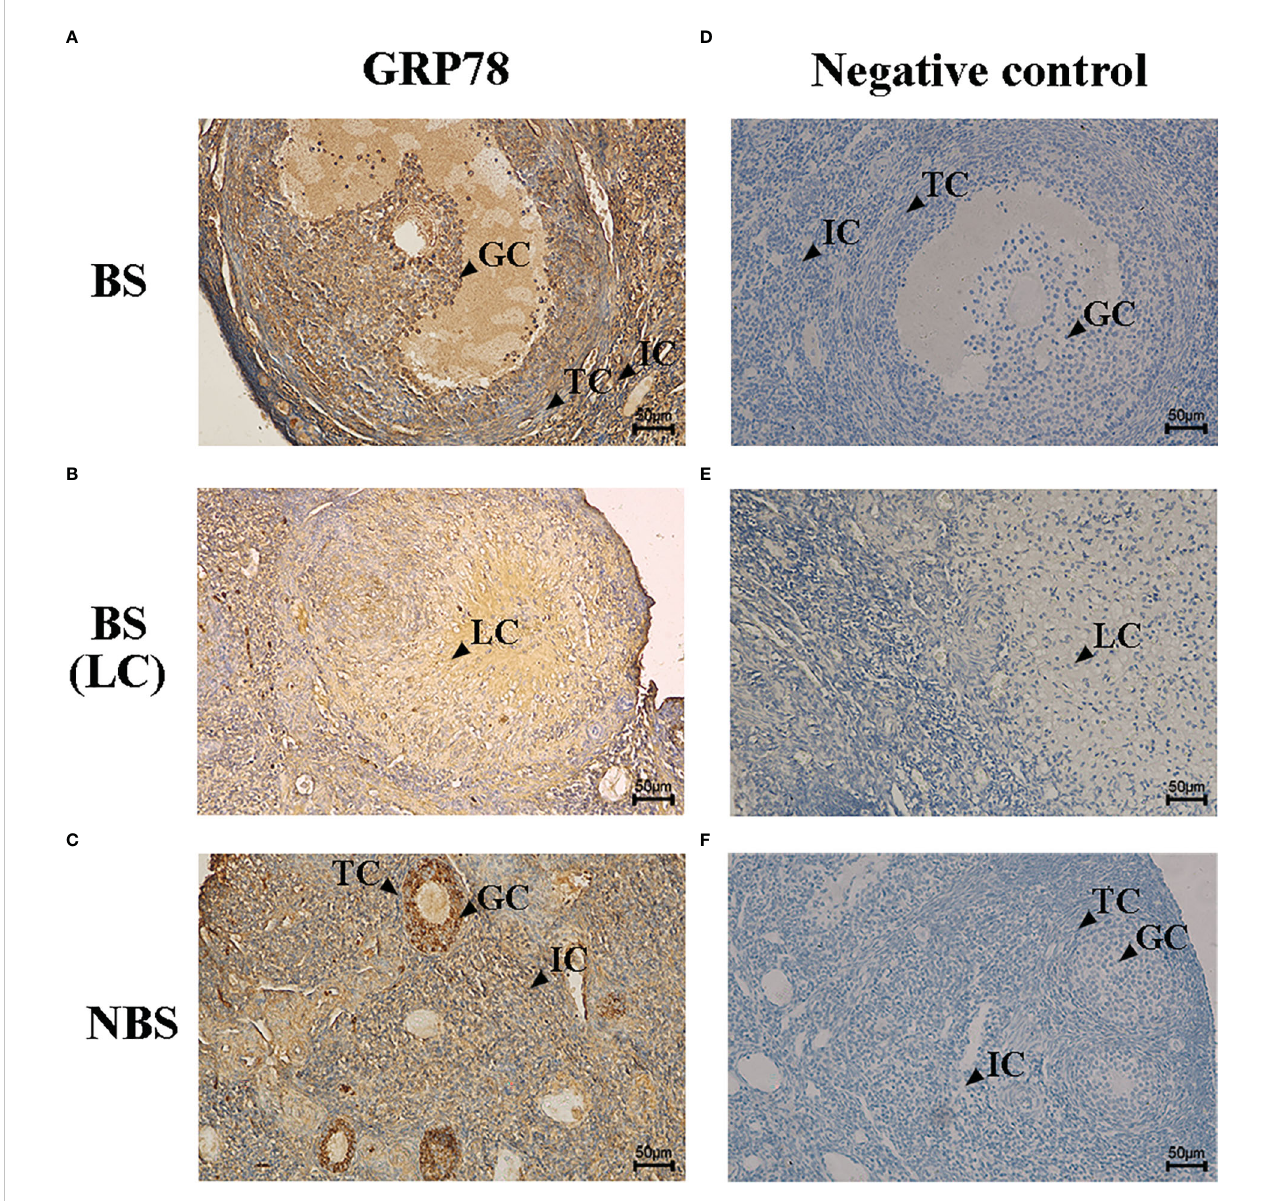
FIGURE 4 Immunohistochemical localization of GRP78 in ovaries of the muskrats during breeding season (A, B) and non-breeding season (C) . The negative control of the ovaries sections in breeding season (D, E) and non-breeding season (F) . BS, breeding season; NBS, non-breeding season. GC, granulosa cells; TC, theca cells; IC, interstitial cells; LC, luteal cells. Scale bars represent 50 m m.